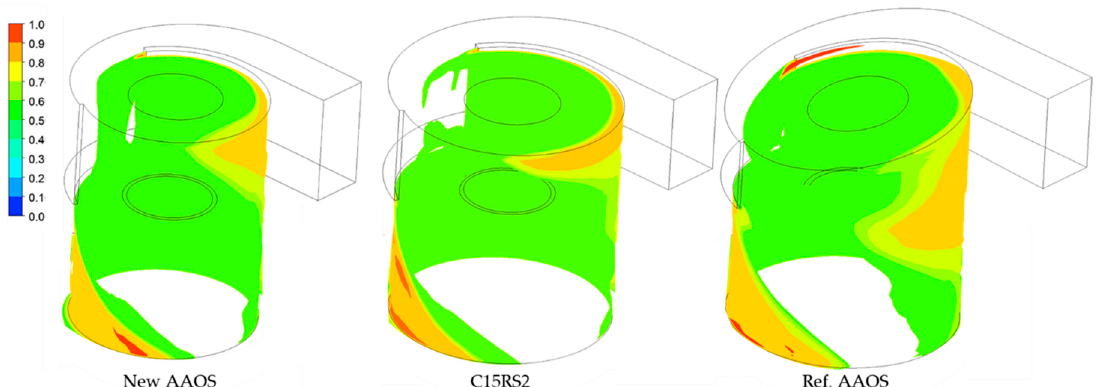
Figure 14. Oil fraction 0.65, 0.8, 1 iso surface.